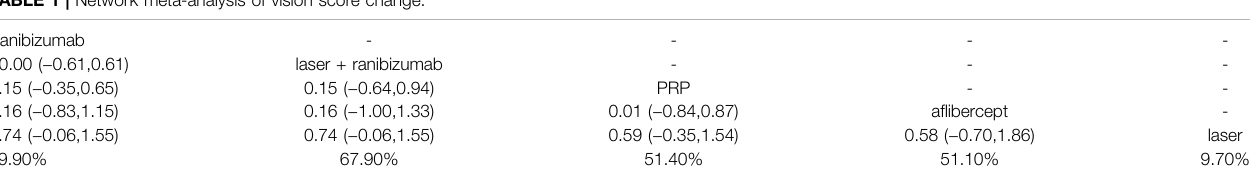
TABLE 1 | Network meta-analysis of vision score change. Ranibizumab